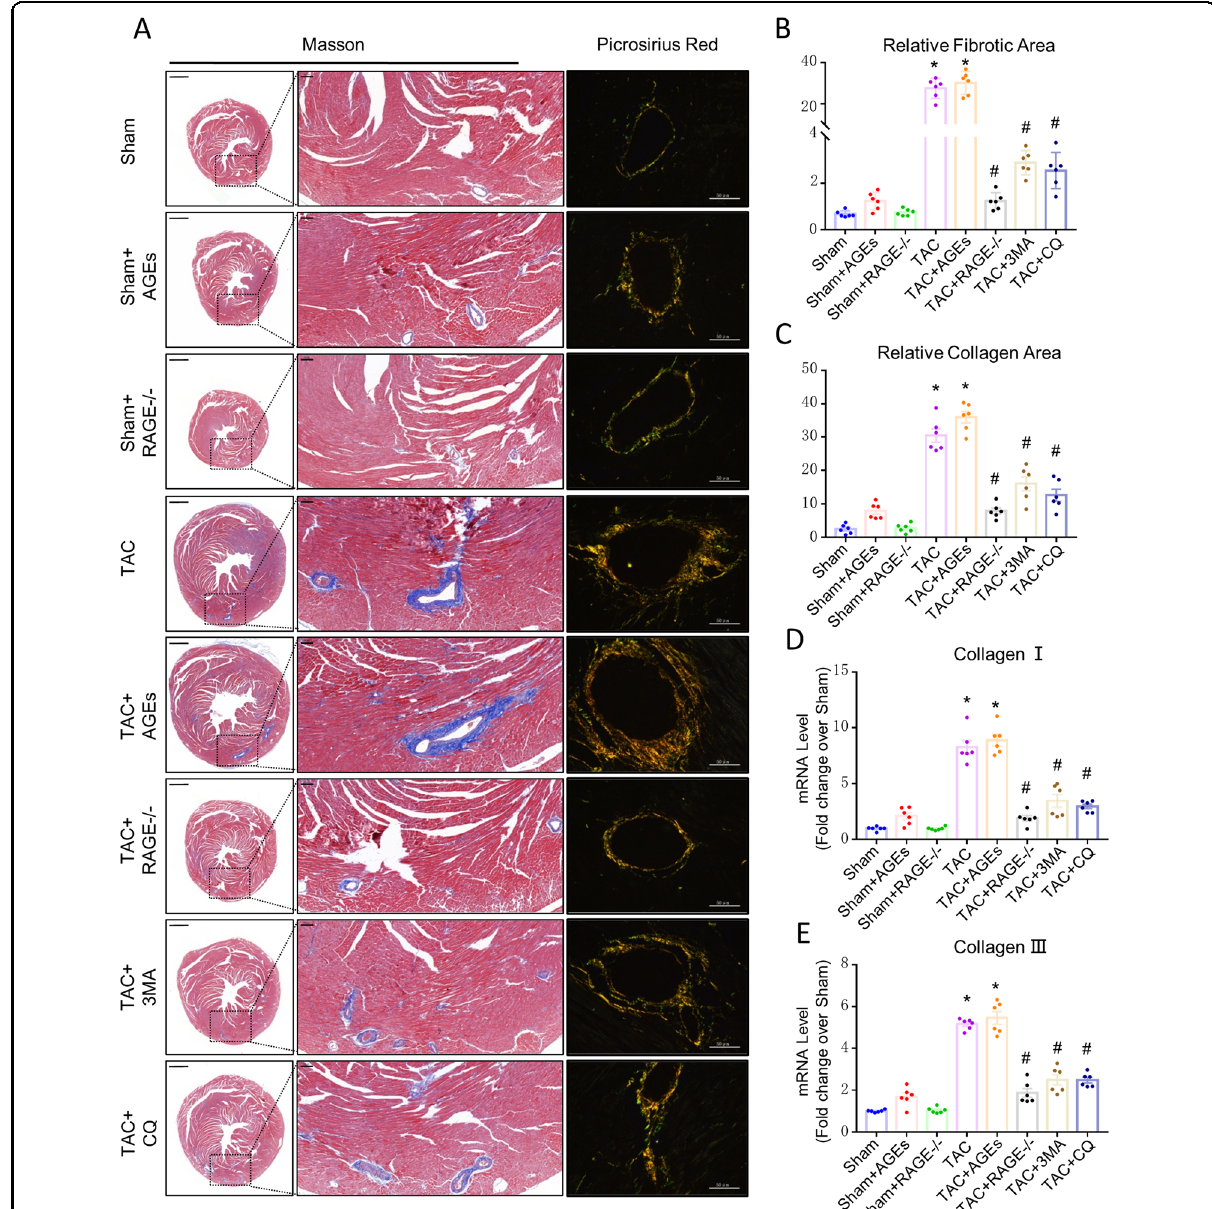
Fig. 2 Effect of AGEs/RAGE or autophagy on cardiac fi brosis after TAC. A Myocardial fi brosis was detected by Masson ’ s trichrome staining (scale bar: transverse sections = 1000 µm, perivascular sections = 200 µm), and perivascular collagen synthesis was detected by a Sirius red-polarized method (scale bar = 50 µm). Blue areas indicate fi brosis. Yellow areas indicate collagen I, and green areas indicate collagen III. The fi brosis area was measured with a quantitative digital image analysis system: fi brotic area ( B ) and collagen deposition area ( C ). mRNAs for fi brosis associated genes collagen I ( D ) and collagen III ( E ) were measured by qPCR. n = 6. Data are presented as mean ± SEM. * p < 0.05 vs. sham group, # p < 0.05 vs. TAC